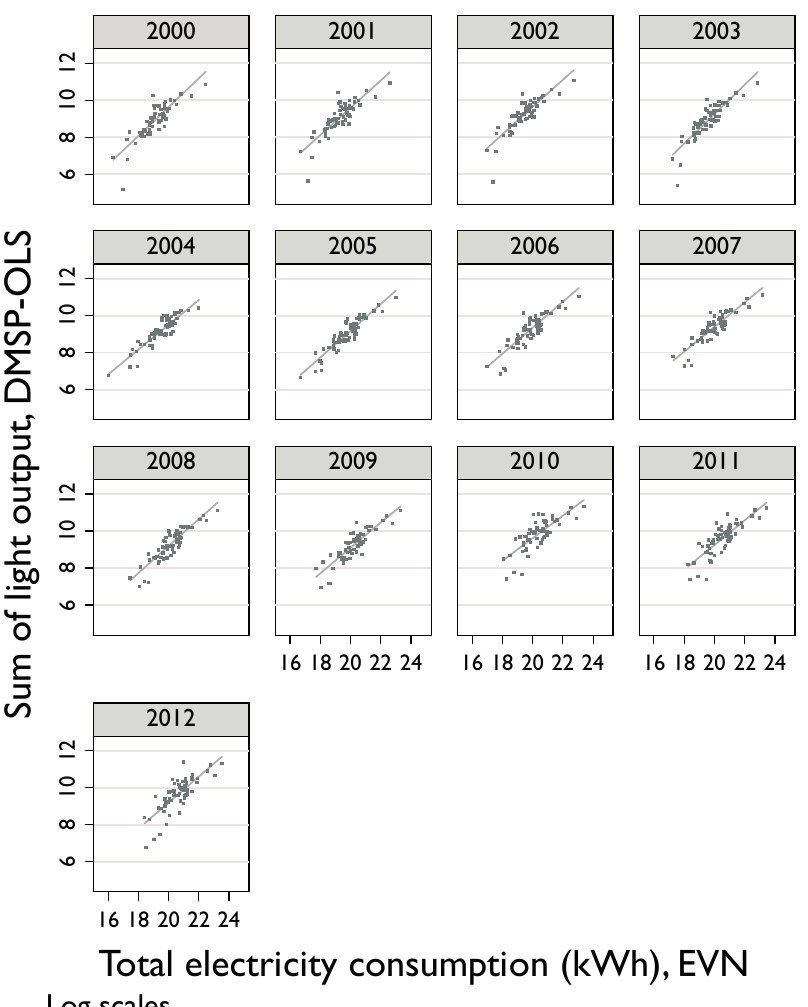
Figure 2. Nighttime brightness and electricity consumption in 68 Vietnam provinces,